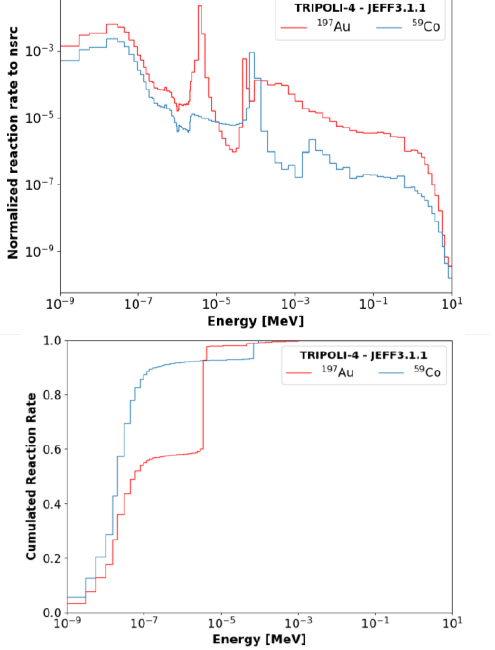
Fig. 3. Distribution of reaction rates and cumulated reaction rates for resonant dosimeters.